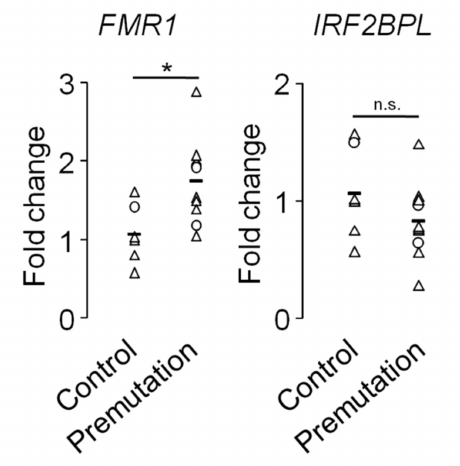
Figure A2. Relative expression of FMR1 and IRF2BPL genes in whole blood of controls and premu- tation donors. Triangles ( ∆ ), female samples; circles (O), male samples. Of the four males of our cohort, only three were available for these assays. The mean is indicated (horizontal bar). *, p < 0.05, Mann-Whitney U-test. n.s., not